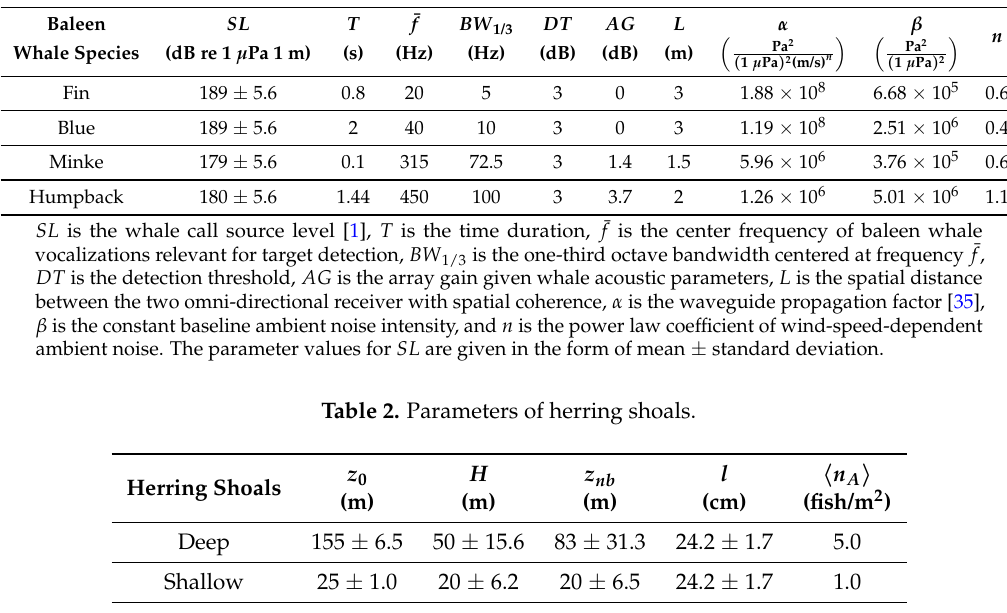
Table 1. Parameters of baleen whale’s auditory reception and signal detection used for detection range estimation in the Gulf of Maine scenario.